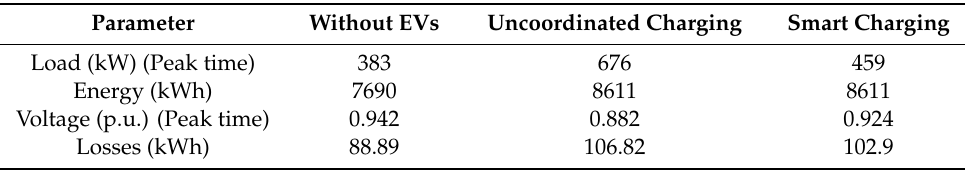
Table 6. Parameter